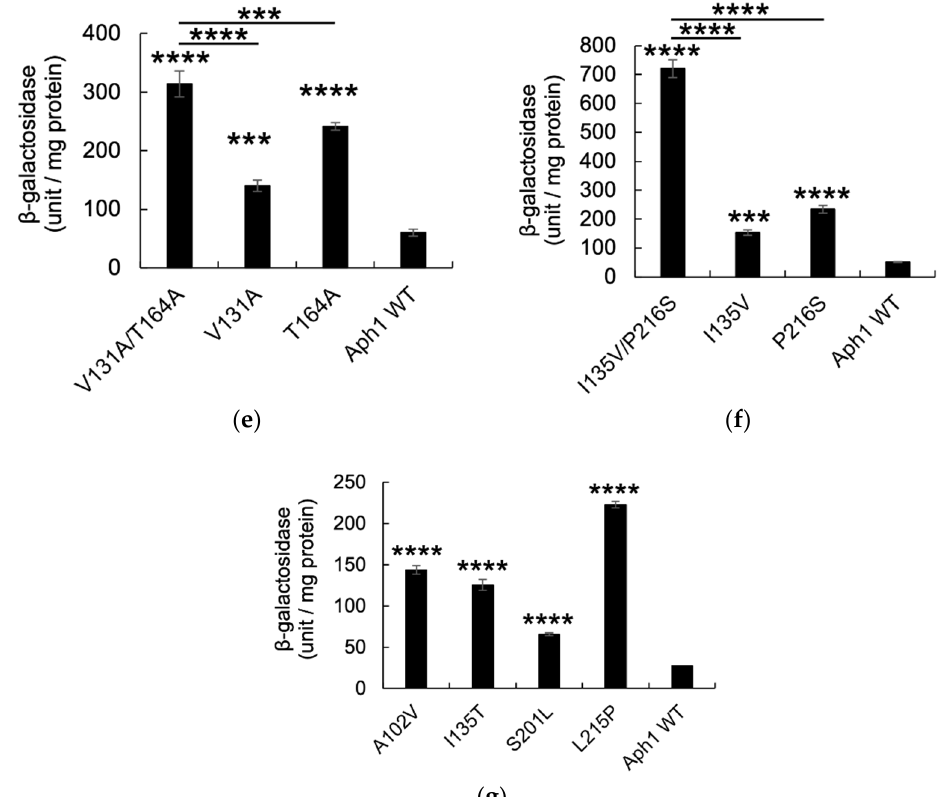
Figure 2. β -Galactosidase activity of Aph1 active mutants in the absence of NCT. Wild-type (WT) or mutant Aph1 was introduced into yeast with PS1, FLAG-Pen2, and APP C55 -Gal4p; Gal4p cleaved from APP C55 -Gal4p activates the reporter gene, lacZ , encoding β -galactosidase. β -Galactosidase activity was assayed in cells containing Aph1 double and single mutants ( a – g ). One unit of β -galactosidase activity corresponds to 1 nmol O -nitrophenol β -galactoside hydrolyzed per minute; it is expressed as units/mg lysate protein. Activity was normalized as relative to the activity of control cells without NCT (52.0 units/mg protein). Results from three independent assays are shown with their standard deviations. Statistical analyses were performed using one-way analysis of variance (ANOVA) followed by Dunnett’s multiple comparison test. Asterisks on each bar indicate p < 0.001 (****), p < 0.001 (***), p < 0.01 (**) or p < 0.05 (*) ( a – g ).